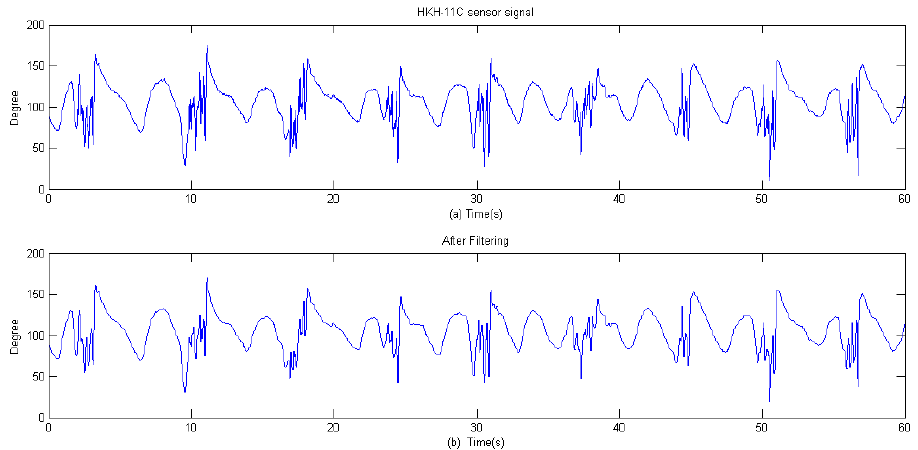
Figure 5. Coughing pattern obtained using HKH-11C sensor. ( a ). Raw coughing pattern. ( b ). Filtered coughing pattern.